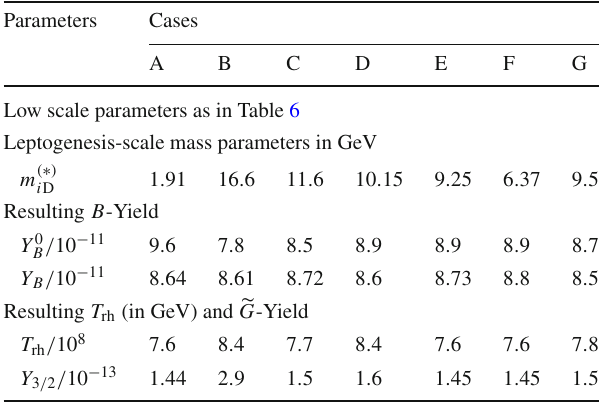
Table 7 Same as in Table 6 but for K = K 2 R and n = 0